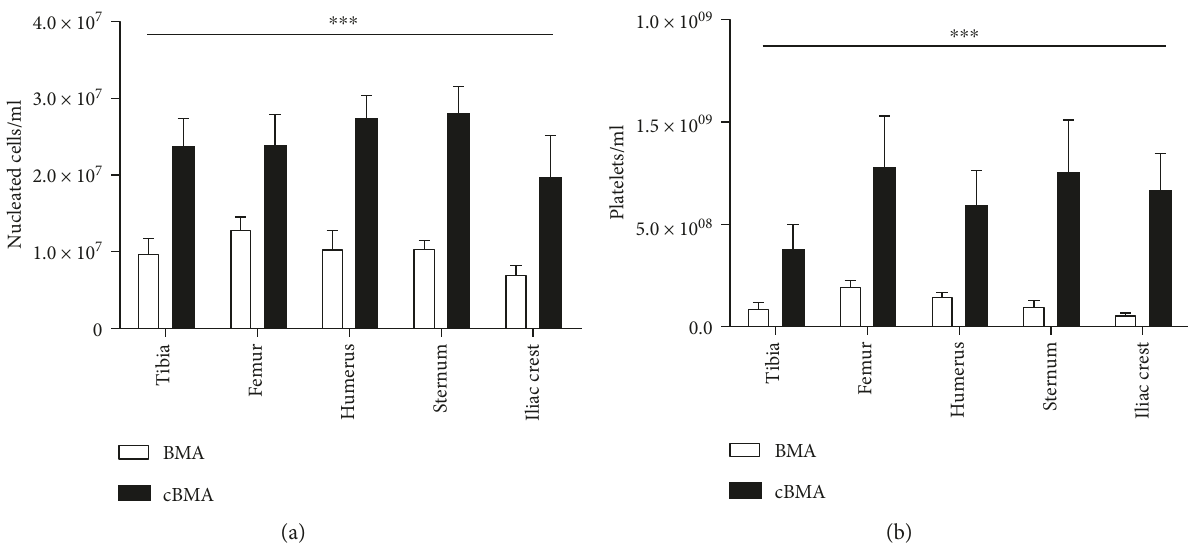
Figure 2: Concentration of nucleated cells (a) and platelets (b) obtained from di ff erent bone marrow sites. Signi fi cant di ff erences were observed before (BMA) and after (cBMA) concentration, but not among the di ff erent sites; ∗∗∗ p < 0 001 .